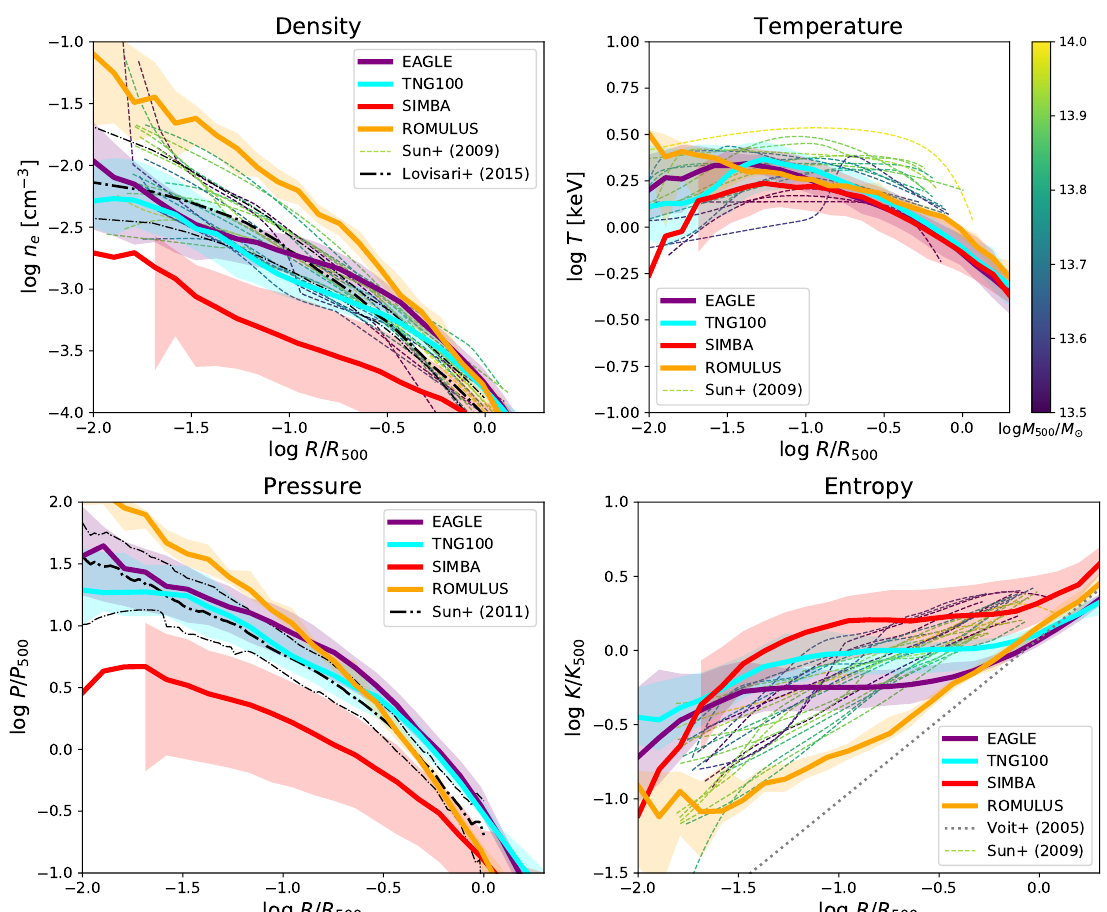
Figure 5. Mass-weighted 3D radial profiles of IGrM density ( top left ), temperature ( top right ), pressure ( bottom left ) and entropy ( bottom right ) in groups with M 500 = 10 13.5 10 14.0 M from the EAGLE ( N = 18 groups, purple), TNG100 − (cid:12) ( N = 35, cyan), SIMBA ( N = 80, red), and ROMULUS ( N = 1, orange) simulations. For the first three, we show profiles at z = 0, while for ROMULUS we have stacked the profiles obtained from the single group in this mass range at five snapshots with z 0.36. Running medians within each simulation are plotted as solid lines, with shaded bands representing the ≤ 1 σ scatter. For comparison, profiles of individual groups in the same mass range derived from X-ray observations [2] are shown as thin dashed lines in three panels, colored by (temperature-derived) halo mass; for pressure, we instead show the SZ-based profiles of the same groups by Sun et al. [212] as black dash-dotted lines (thick and thin ones for the median and 1 σ scatter, respectively). In the top-left panel, the stacked density profile from X-ray observations of Lovisari et al. [5] is shown in the same fashion, while the grey dotted line in the bottom right panel represents the “base line” K ∝ r − 1.1 entropy profile seen in non-radiative simulations (e.g., Lewis et al. [95], Voit et al. [96]). With the exception of temperature at large radii, there is little agreement between simulations. The entropy profiles in particular are also clearly different from what is observed in all four cases, even for simulations such as EAGLE and TNG100 that approximately reproduce the observed pressure profile. In general, stronger AGN feedback prescriptions raise entropies and reduce densities and